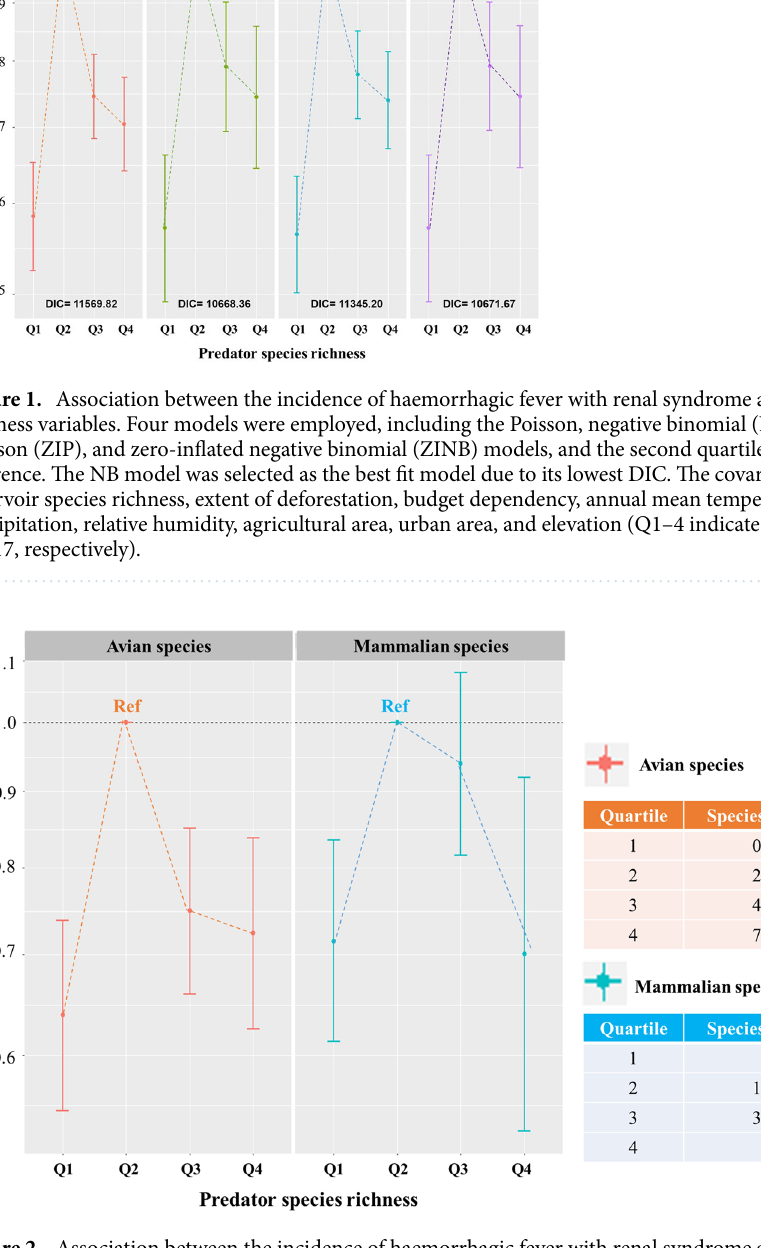
Figure 2. Association between the incidence of haemorrhagic fever with renal syndrome and predator species richness according to the predator class. Negative binomial models were employed, and the second quartile served as the reference. The covariates included reservoir species richness, extent of deforestation, budget dependency, annual mean temperature, annual precipitation, relative humidity, agricultural area, urban area, and